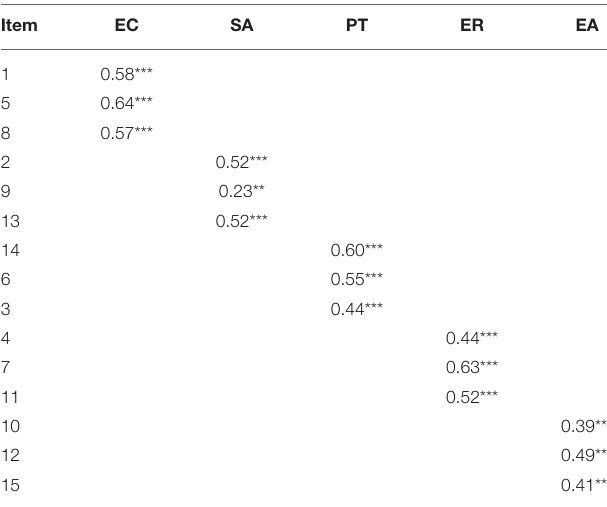
TABLE 4 | Item-total correlations.